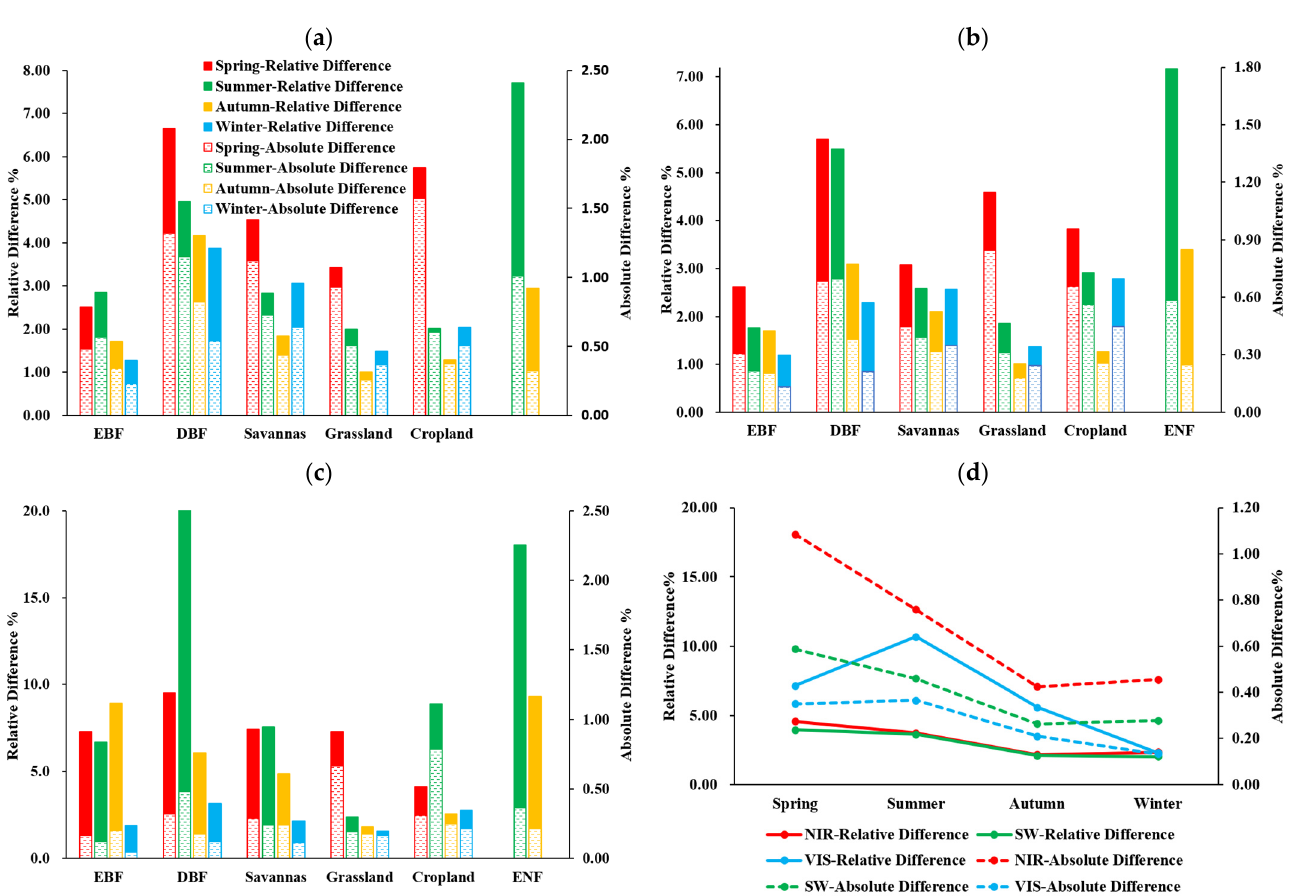
Figure 12. Statistics of the seasonal distribution for monthly albedo differences in NIR ( a ), SW ( b ), VIS ( c ) and the comprehensive data for each season based on each study site ( d ). Table 5. Extreme monthly differences in albedo due to BRDF temporal smoothing in all study